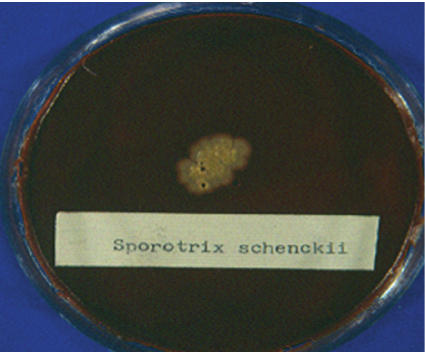
Figure 3: Yeast-like cells colony of Sporothrix schenckii isolated from conjunctiva granular tissue in, after five days of incubation in 5% CO 2 ambient in blood agar medium.